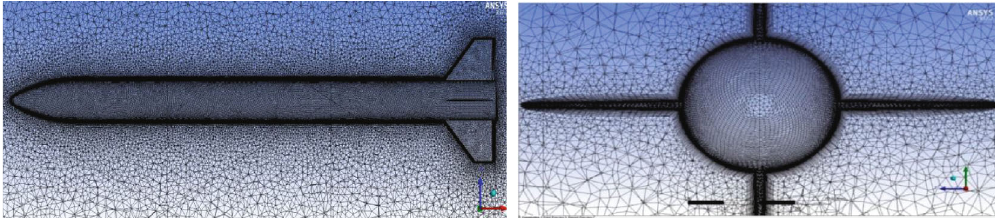
Figure 2: Mesh generation on the missile body and tail fi ns.